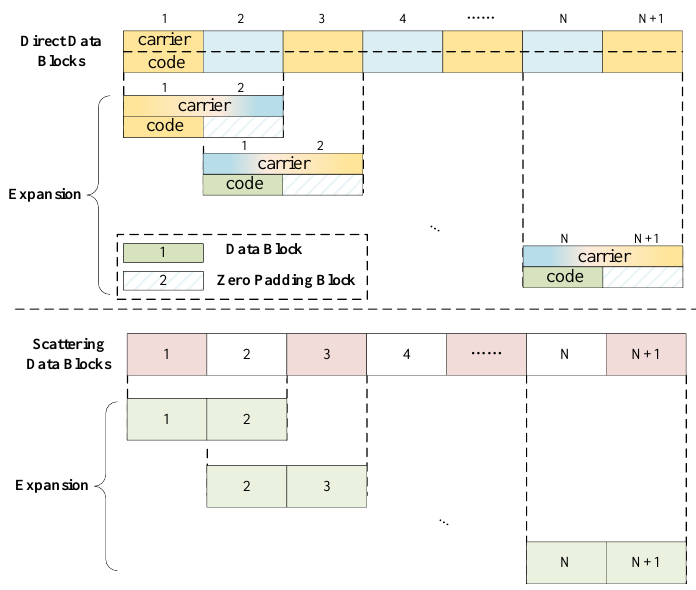
Figure 6. Schematic diagram of expansion operation.